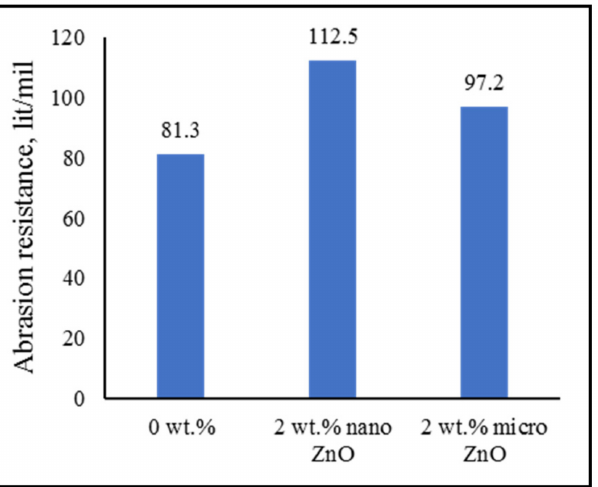
Figure 1. Values of abrasion resistance for the water-borne acrylic coating with or without ZnO particles.